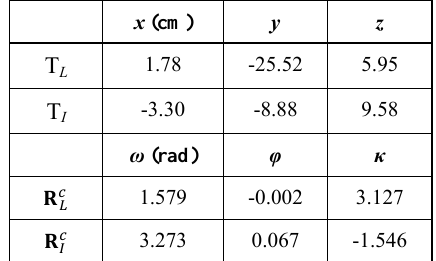
Table 1. Summary of system mounting parameters